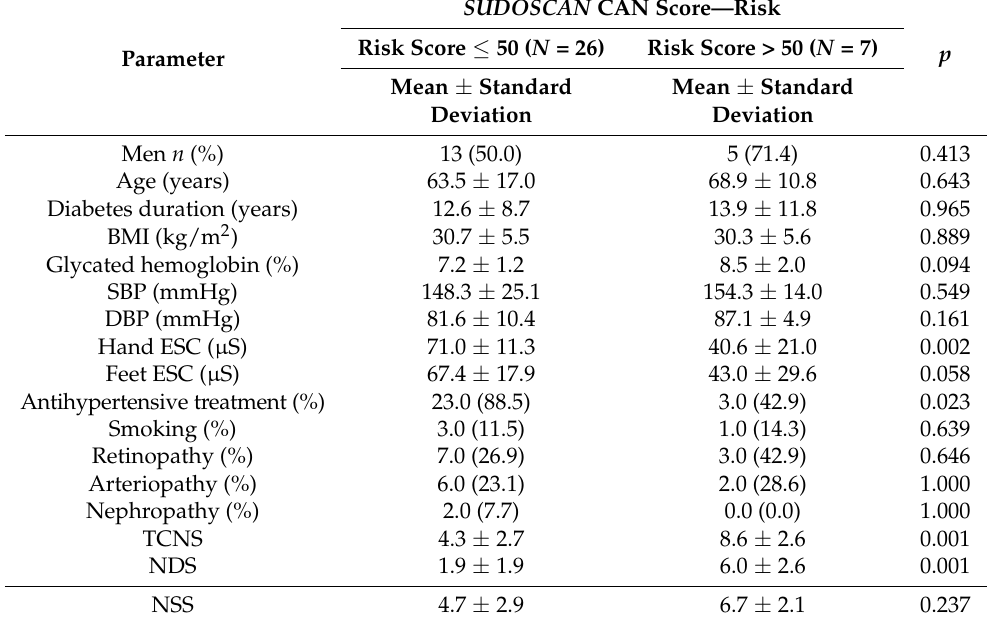
Table 2. Comparison of different parameters between the group of patients at no (or low) risk for CAN (SUDOSCAN CAN risk score < 50%) with the one composed of patients found to be at high risk (SUDOSCAN CAN risk score ≥ 50%).